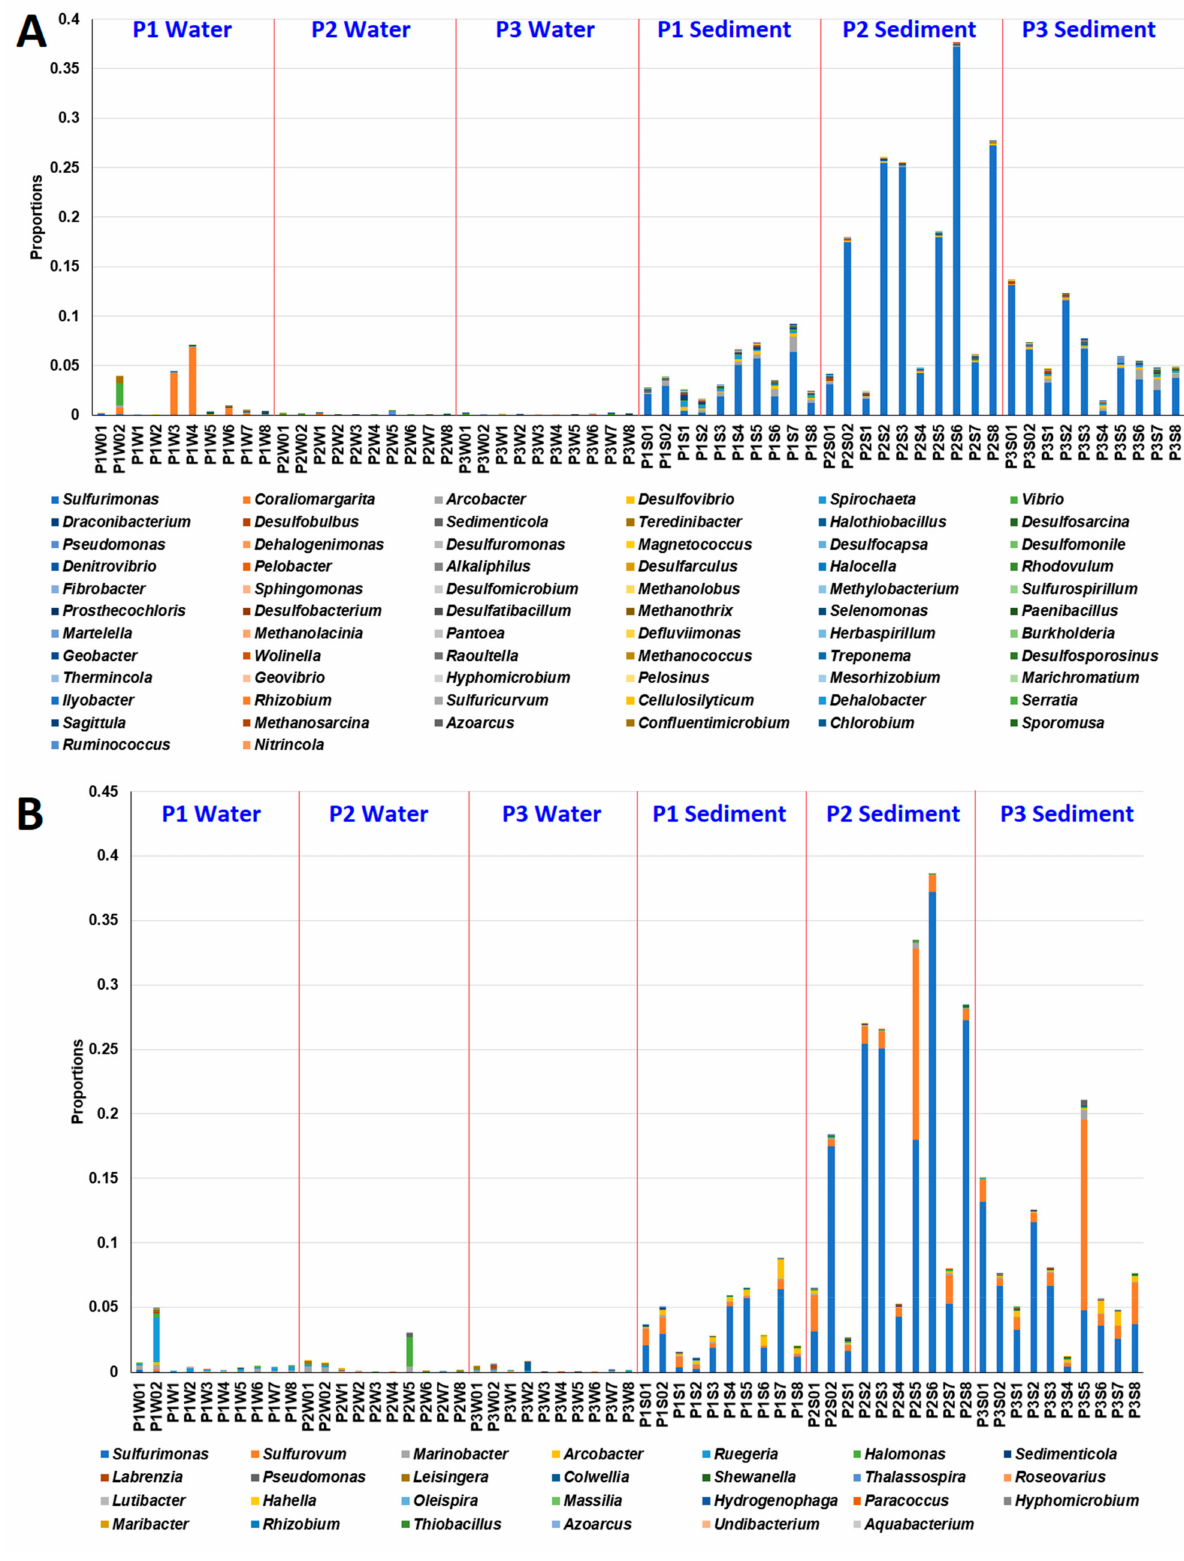
Figure 4. Proportions of nitrogen fixation (nitrogen => ammonia) ( A ) and denitrification (nitrate => nitrogen) ( B ) associated microbial communities among the water and sediment of small milkfish ponds. P1: control small milkfish pond. P2: small milkfish pond with the addition of MG. P3: small milkfish pond with the addition of MG and MG-degrading